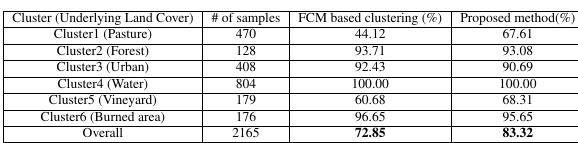
Table 1: Comparison of the class-wise Producer accuracies on the Sardinia